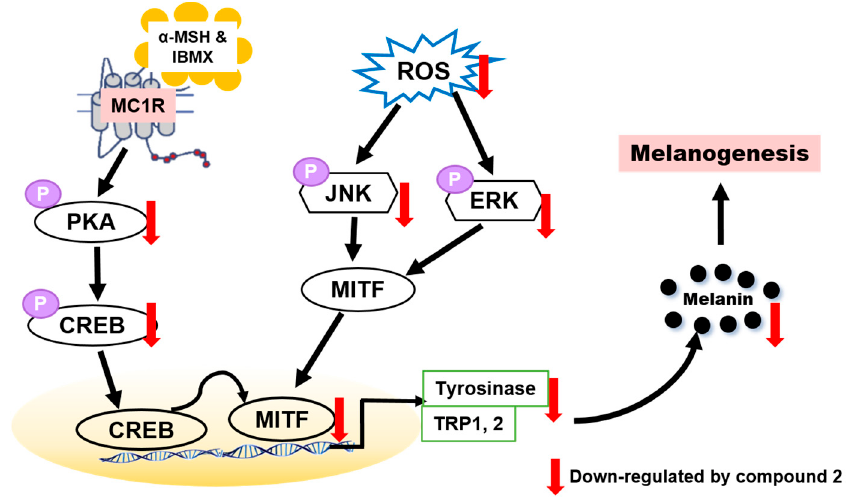
Figure 8. Proposed mechanism of action of compound 2 against melanogenesis.